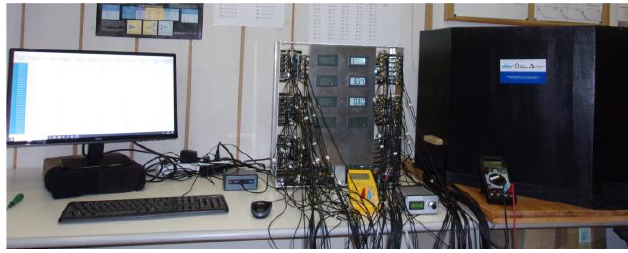
Fig. 6. The experimental setup consisting of the detector part and the DAQ system. The S 3 detector is surrounded by a black light-tight box